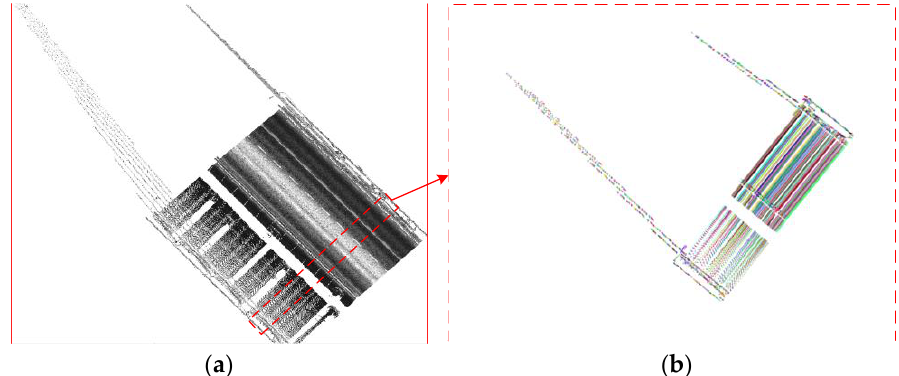
Figure 12. ( a ) Original point cloud; ( b ) scan line extracted from the original point cloud.